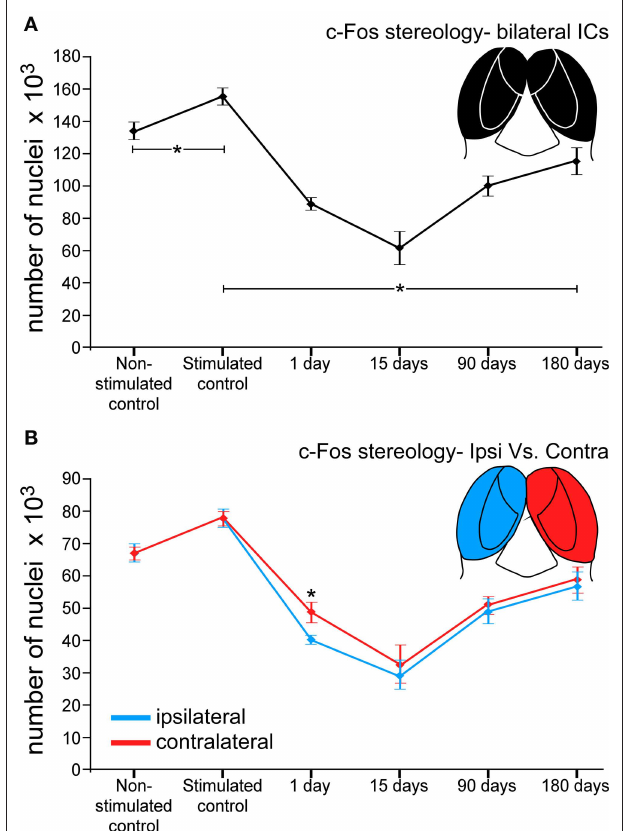
Figure 6 | graphs showing number of c-Fos immunoreactive neuronal nuclei in the iC after sound stimulation at different times after lesions of the auditory cortex. (A) The number of c-Fos immunoreactive neuronal nuclei significantly drops at 1 day (42%) and 15 days (55%) after the cortical lesion. Ninety and 180 days post-lesion, the number of immunoreactive neurons following sound stimulation recovers, but still remains below control values (33% at 90 days and 23% at 180 days). *Asterisks denote the significant differences between the control groups and the stimulated control and each lesioned group, and means the average value ± 2SD (error bars). (B) The number of c-Fos immunoreactive neurons differs between the sides ipsi- and contralateral to the cortical lesion. At 1 day after the lesion, the number of c-Fos immunoreactive neurons is significantly lower in the ipsilateral side. At 15, 90, and 180 days the number of immunoreactive neurons is comparable, although slightly lower in the ipsilateral